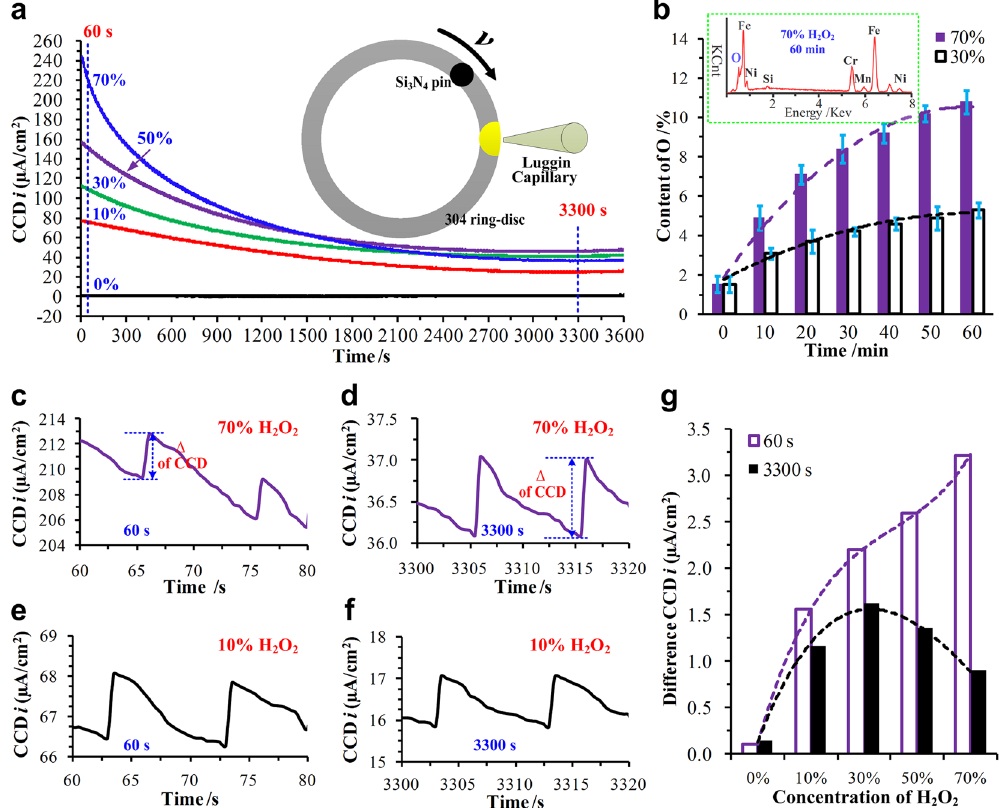
Figure 1. Behaviours of the CCDs. ( a ) Trend of the CCDs of the 304 ring-discs in different H 2 O 2 solutions, ( b ) the average oxygen contents of the wear surfaces subjected different oxidation times with 70% and 30% H 2 O 2 solutions, CCDs in the 70% H 2 O 2 solution at ( c ) 60 s and ( d ) 3300 s, CCDs in the 10% H 2 O 2 solution at ( e ) 60 s and ( f ) 3300 s, and ( g ) increasing amplitudes of the CCDs for one cycle in different H 2 O 2 solutions at 60 s and 3300